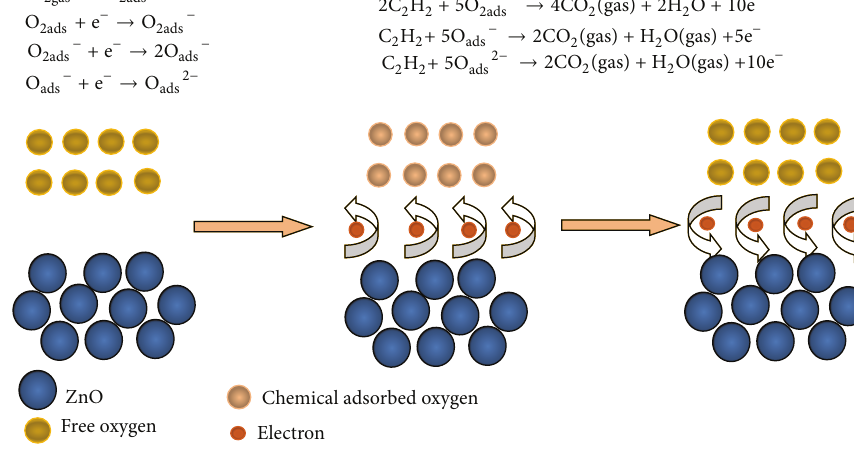
Figure 9: Schematic diagram of the gas-sensing reaction process.